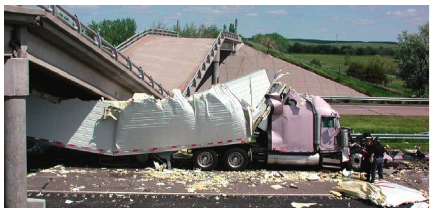
Figure 1: Bridge collapse due to a truck hitting a support column in the US state of Nebraska in